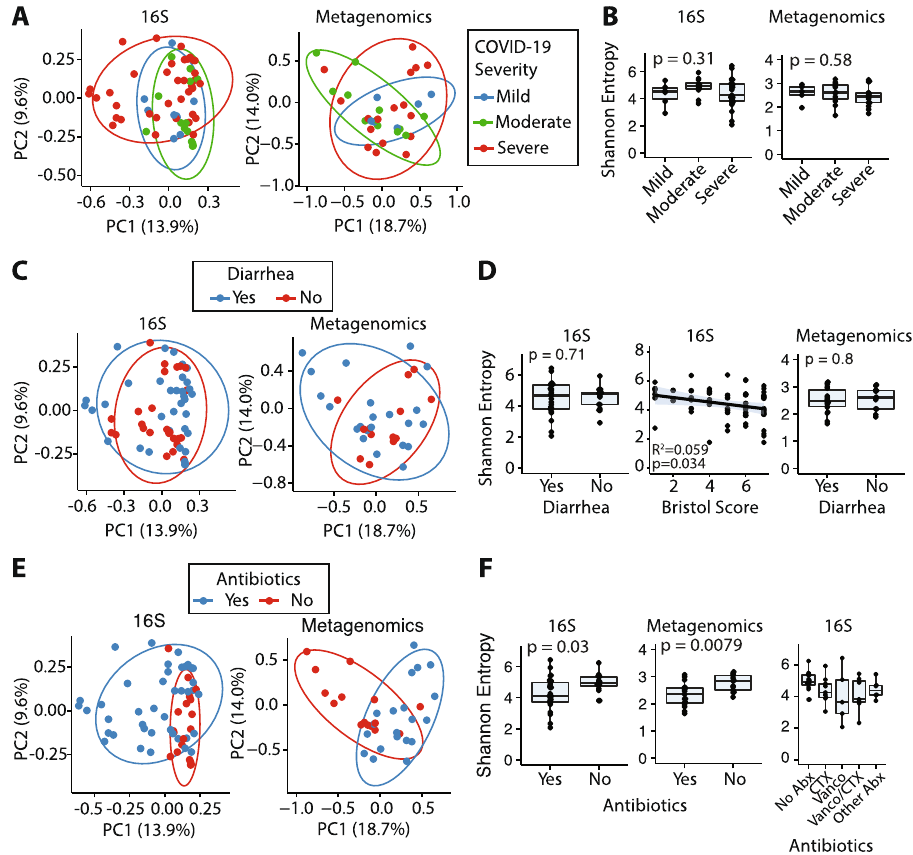
Figure 4. Gut microbiome and fecal SARS-CoV-2 genome sequencing of COVID-19 patients. ( A ) PCoA (Bray–Curtis dissimilarity) of 16S rRNA gene amplicon and shotgun metagenomic sequencing of fecal samples from donors stratified by COVID-19 severity. ( B ) Alpha diversity (Shannon entropy) is not significantly altered in mild, moderate or severe COVID-19. (C) PCoA (Bray–Curtis dissimilarity) of 16S rRNA gene amplicon and shotgun metagenomic sequencing of fecal samples from donors with and without diarrhea. ( D ) Gut microbiome alpha diversity (Shannon entropy) in patients with and without diarrhea and as relates to the Bristol score of each sample. ( E ) PCoA (Bray–Curtis dissimilarity) of 16S rRNA gene amplicon and shotgun metagenomic sequencing of fecal samples from patients receiving or not receiving antibiotic therapy. ( F ). Gut microbiome alpha diversity (Shannon entropy) is reduced in hospitalized COVID-19 patients recently or currently receiving antibiotic therapy (Abx). Boxplots show median + / −